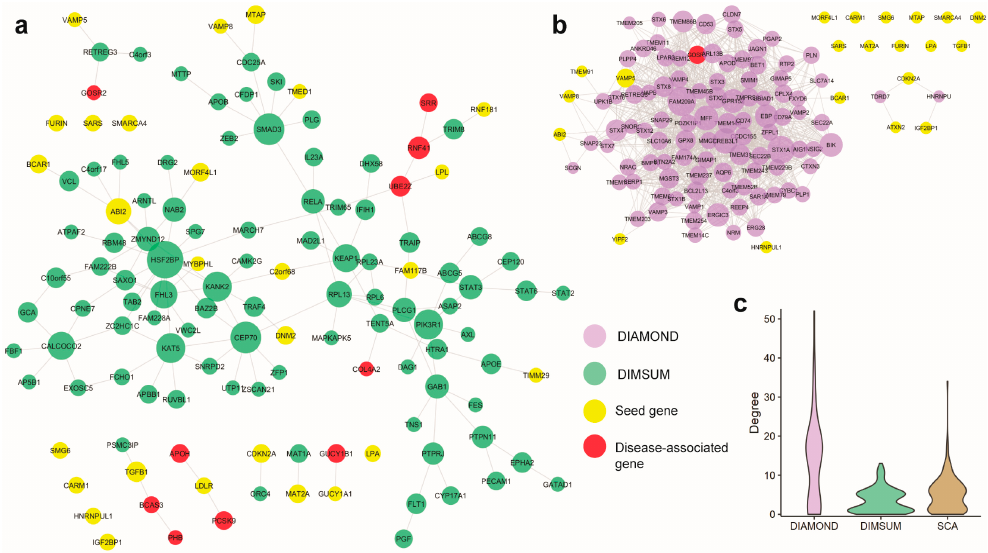
Figure 4. Comparison of Coronary Artery Disease (CAD) modules discovered by the three methods. ( a ) Largest connected component and satellite components detected by DIMSUM; yellow nodes represent the seed genes, and red nodes represent disease-associated genes that are supported by literature. ( b ) Large and high-density module detected by DIAMOnD. DIMSUM identifies ten CAD associated genes, whereas DIAMOnD identifies only one. ( c ) Degree distribution of the modules generated by each method, shows DIMSUM does not tend to grow a highly dense clique and it is not biased toward the hubs with very high node